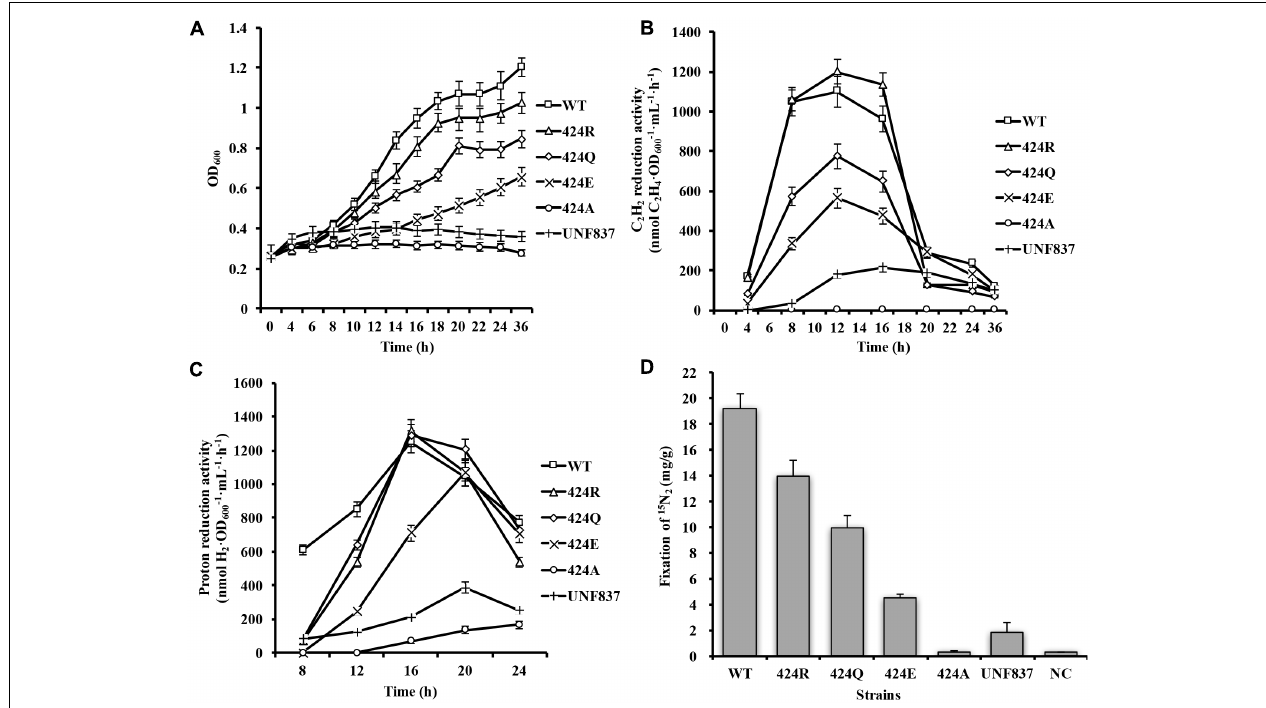
FIGURE 2 | Diazotrophic culture of each strain in shake flask. (A) Anaerobic growth in shake flask. Initial OD 600 of each strain was ∼ 0.25. OD 600 was measured every 4 h. (B) Acetylene reduction activity during serum bottle culture. 1 mL bacterial solution was placed in 10-mL bottle under 90% Ar/10% C 2 H 2 atmosphere and reacted for 30 min. (C) Proton reduction activity during serum bottle culture under 100% Ar condition. (D) Nitrogen fixation activity during serum bottle culture. Cells were collected after 12 h of incubation in 15 N 2 atmosphere, and 15 N 2 amount was measured by freeze-drying